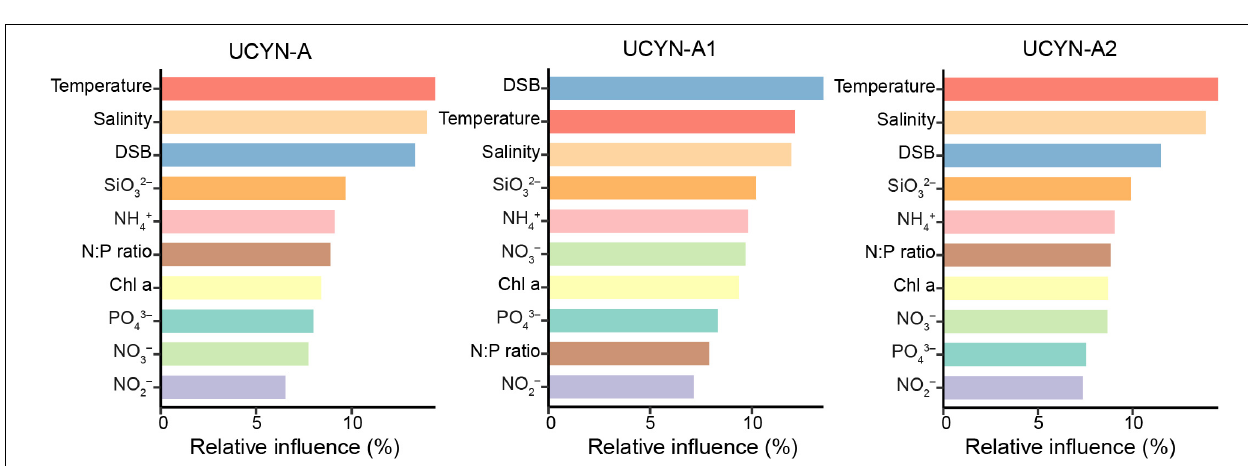
FIGURE 6 | Aggregated boosted tree (ABT) analysis shows the relative effect of each environmental factor on UCYN-A community composition. Environmental variables include temperature, salinity, the distance from sea surface to bottom (DSB), silicate (SiO 32 − ), ammonium (NH 4 + ), chlorophyll a (Chl a ), nitrate (NO 3 − ), nitrite (NO 2 − ), phosphate (PO 43 − ), and N:P ratio